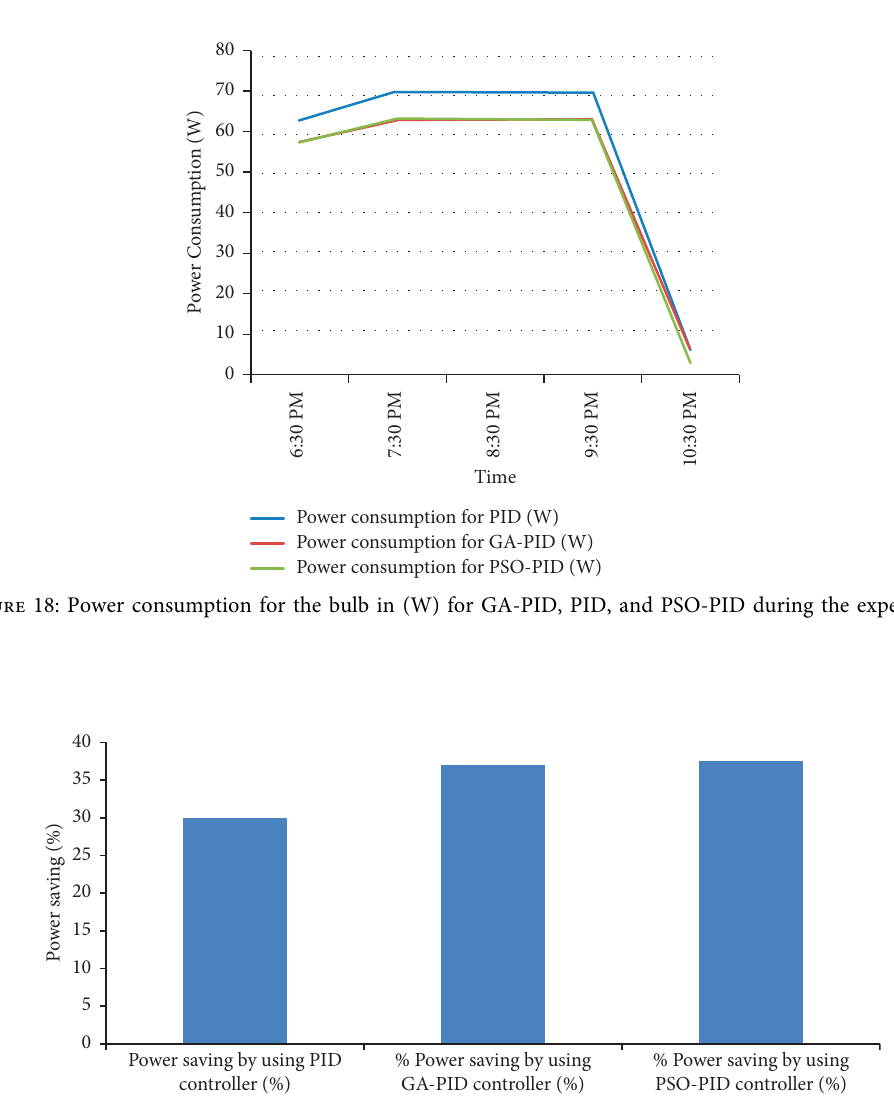
Figure 19: Power saving w.r.t conventional bulb.